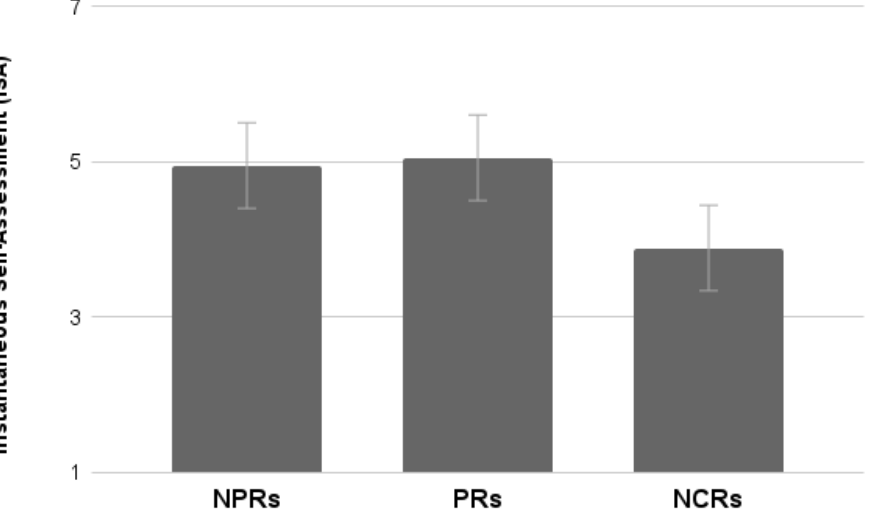
Figure 20. ISA score by Group (NPRs vs. PRs vs. NCRs). Error bars denote 0.95 confidence intervals.